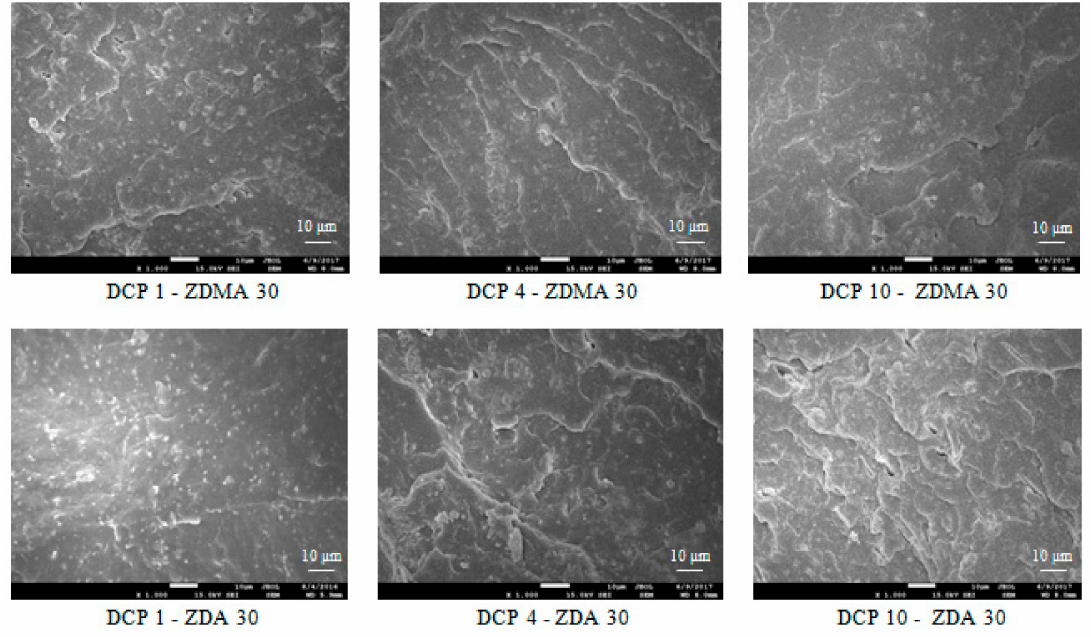
Figure 12. SEM images of composites cured with different content of